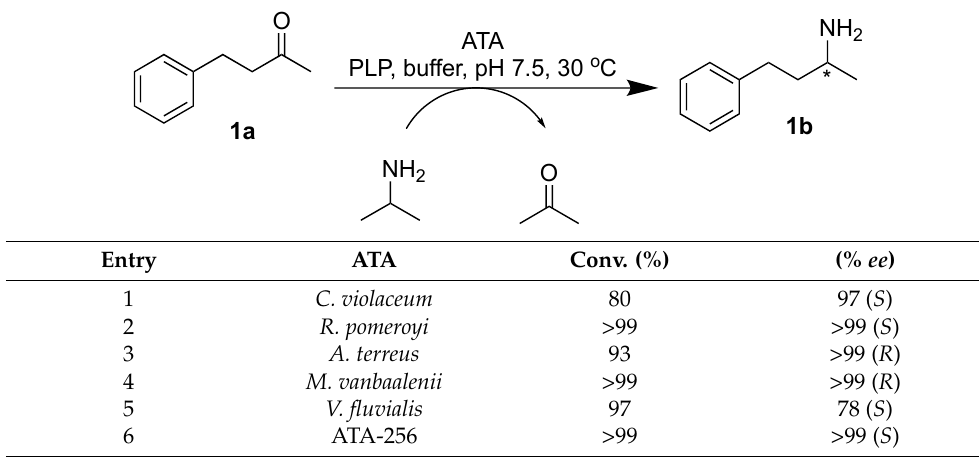
Table 1. Conversions and enantiomeric excess (% ee ) values of amine product 1b, obtained by asymmetric synthesis using isopropylamine (IPA) as the donor and crude cell lysate from Escherichia coli containing the overexpressed ATA.